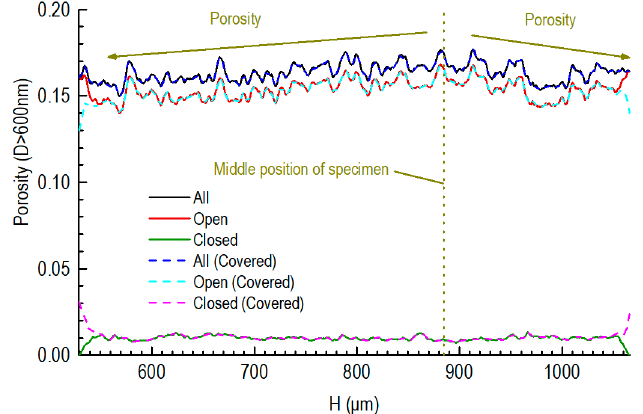
Figure 9. Axial porosity profile of unoxidized graphite component far away from the SiC coating.